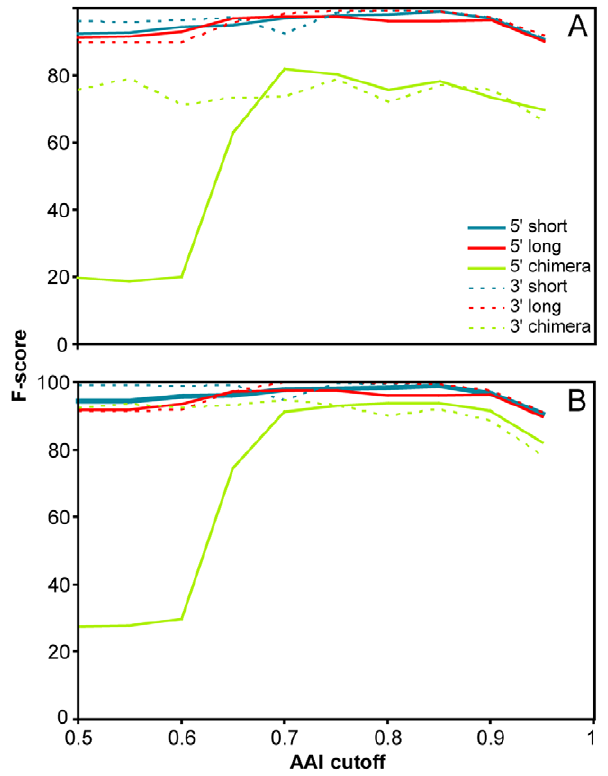
Figure 2. Effect of varying d (the minimum identity required between two protein sequences to be used for correction) on ORFcor performance measured using the F-score. Simulations using test datasets # 1 and # 2 are shown in panels A and B, respectively.